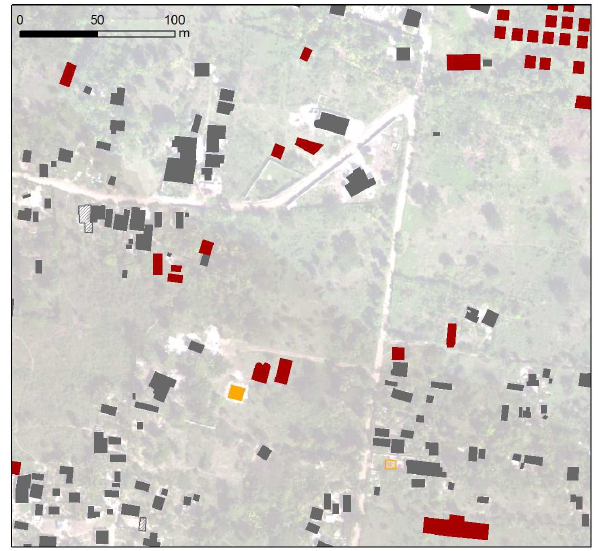
Figure 2 - Evolution of buildings and shelters in Jacmel area, at 3 dates: before, just after and 18 months after the